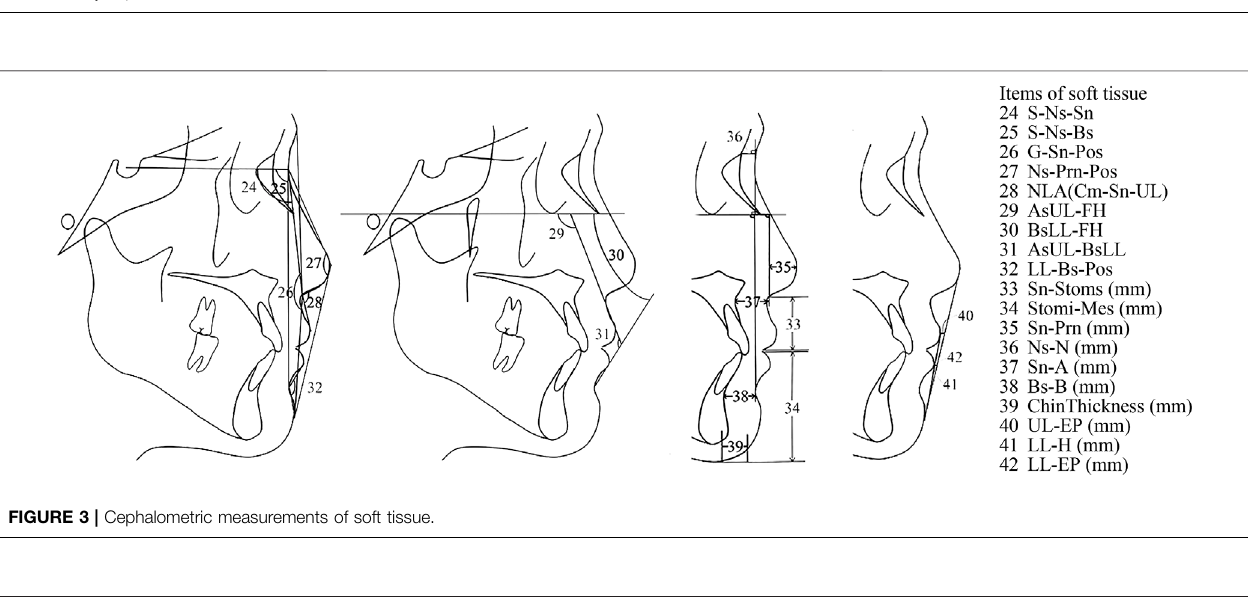
FIGURE 3 | Cephalometric measurements of soft tissue.